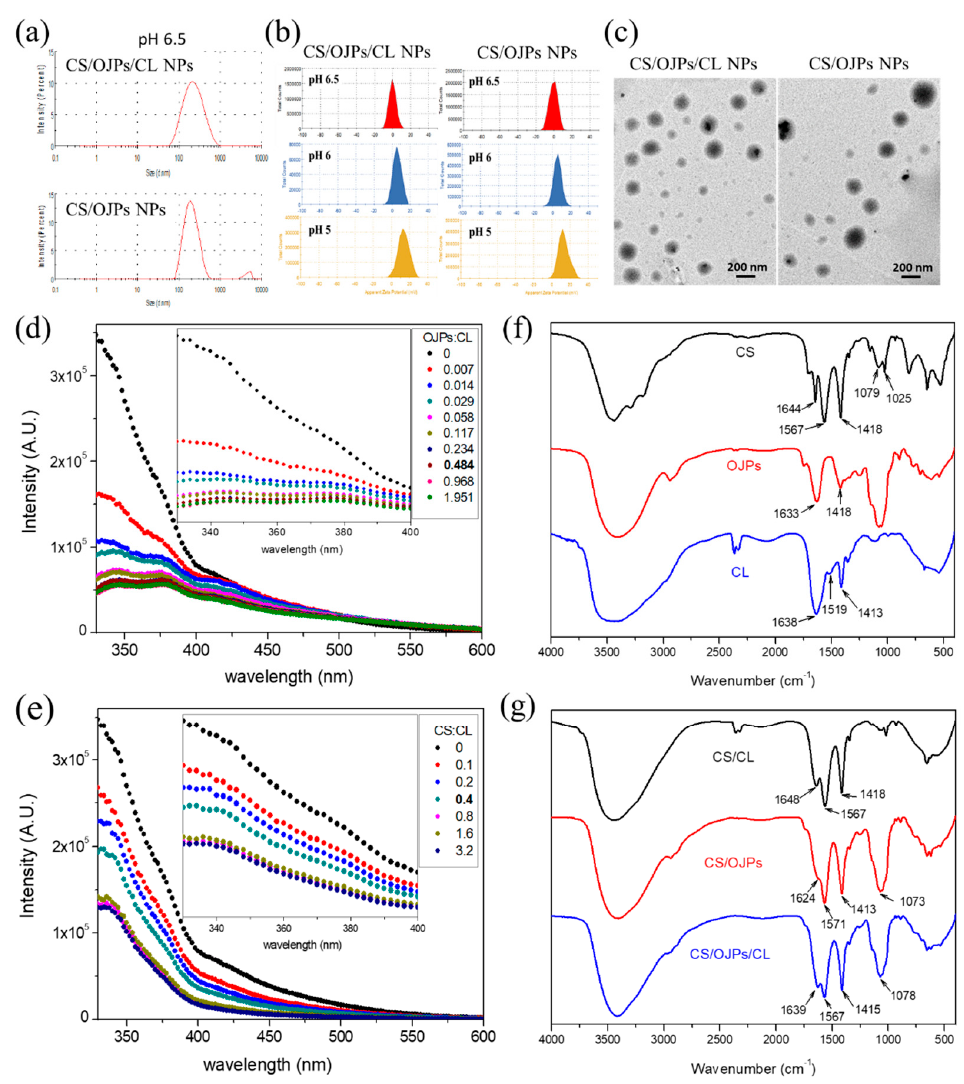
Figure 2. Characterization of CS/OJPs and CS/OJPs/CL NPs: ( a ) size distribution curve, ( b ) zeta potential curve, ( c ) TEM micrographs. Fluorescence spectra: ( d ) the mixtures prepared by adding OJPs to CL aqueous solution and ( e ) the mixtures prepared by adding CS to CL aqueous solution. FTIR spectra: ( f ) CS, OJPs and CL and ( g ) CS/OJPs and CS/OJPs/CL NPs.